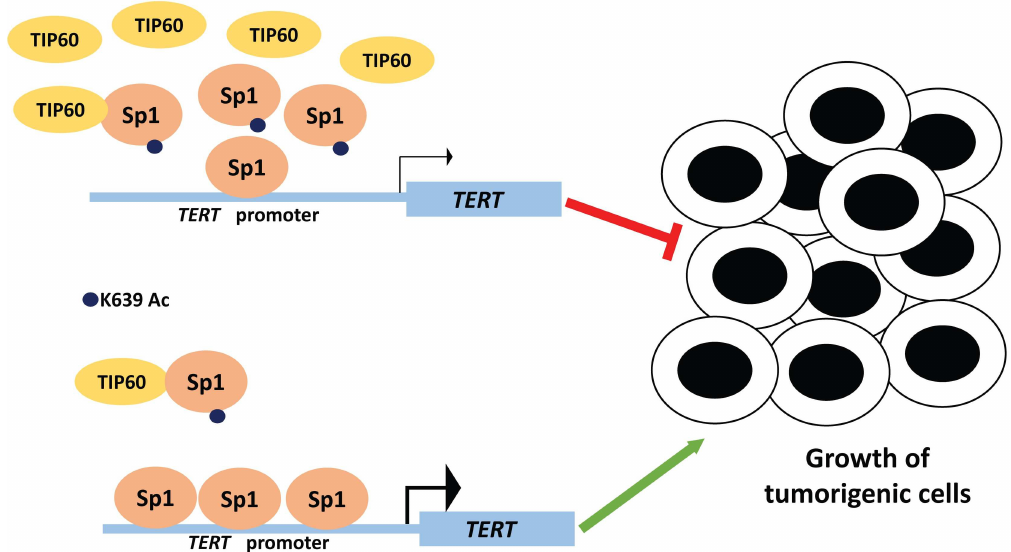
Fig 6. Model of TIP60-mediated TERT repression. TIP60 inhibits expressionof TERT by acetylatingSp1. Decrease in TIP60 levels increasesoccupancyof Sp1 on TERT promoterresultingin increasedexpressionof TERT and subsequently tumor